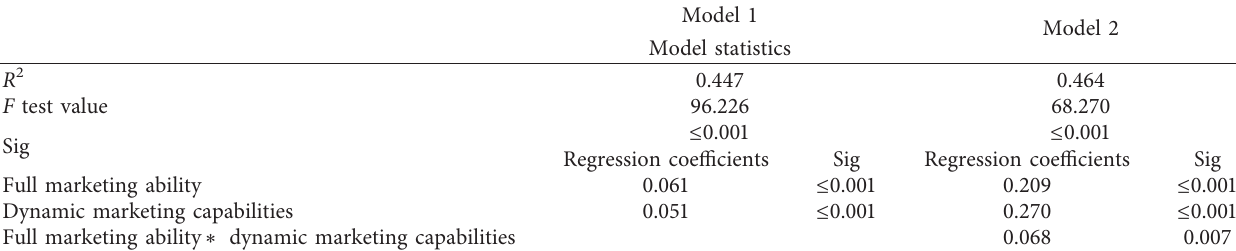
Table 7: Analysis of the adjustment effect of dynamic marketing capabilities (full marketing capabilities ➔ sustainable competitive